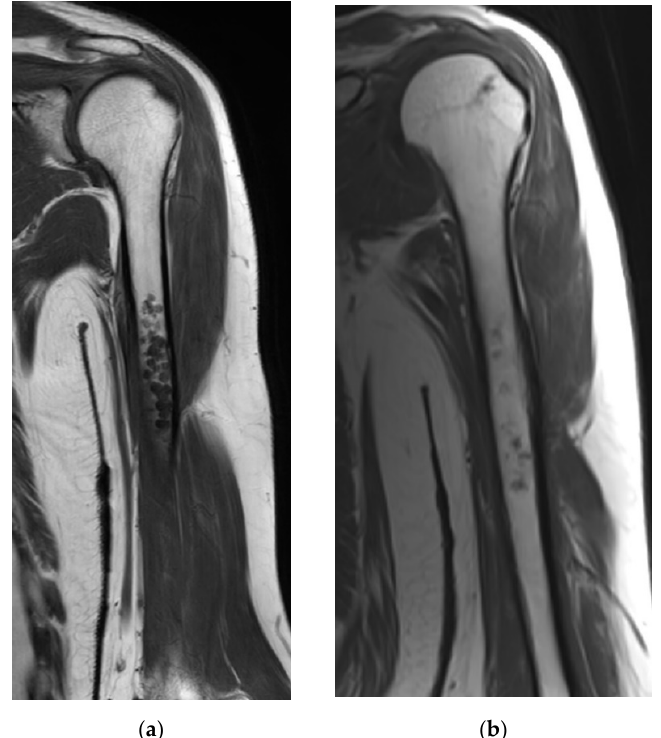
Figure 4. ( a , b ): Coronal Spin Echo T1 weighted images of the same cartilaginous tumor four years apart. Almost complete replacement of the cartilaginous tumor by normal bone marrow fat.